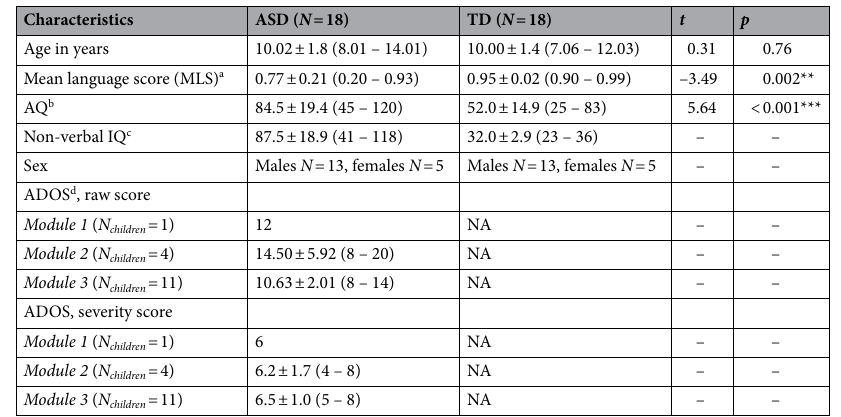
Table 1. Demographic information for ASD and TD groups of children, M ± SD (range). We run t -tests to compare the characteristics of ASD and TD groups of children. The significance is labeled with * p < 0.05, ** p < 0.01, *** p < 0.001. a Mean language score (MLS) is a standard average score (from 0 to 1) across all